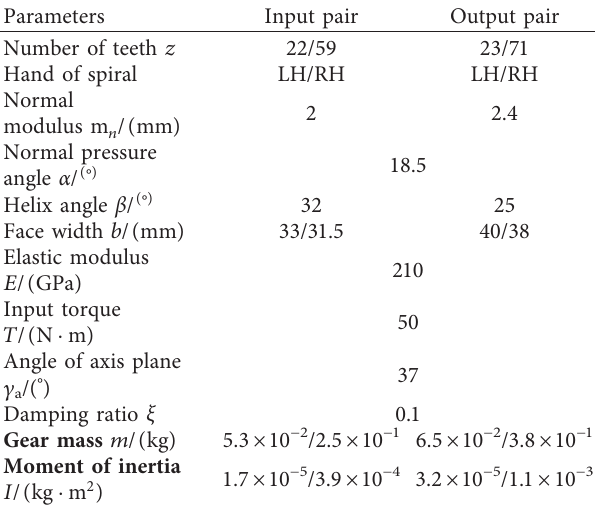
Table 1: Basic parameters of the gear